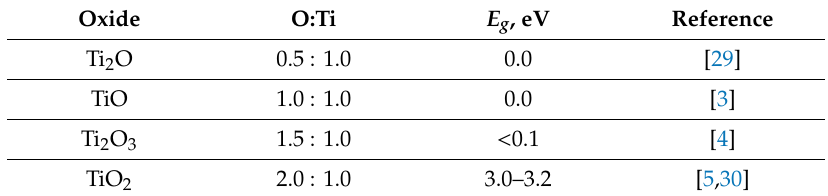
Table 2. Oxygen content (per titanium atom) and band gap energy E g for various titanium oxides. Oxide O:Ti E g , eV